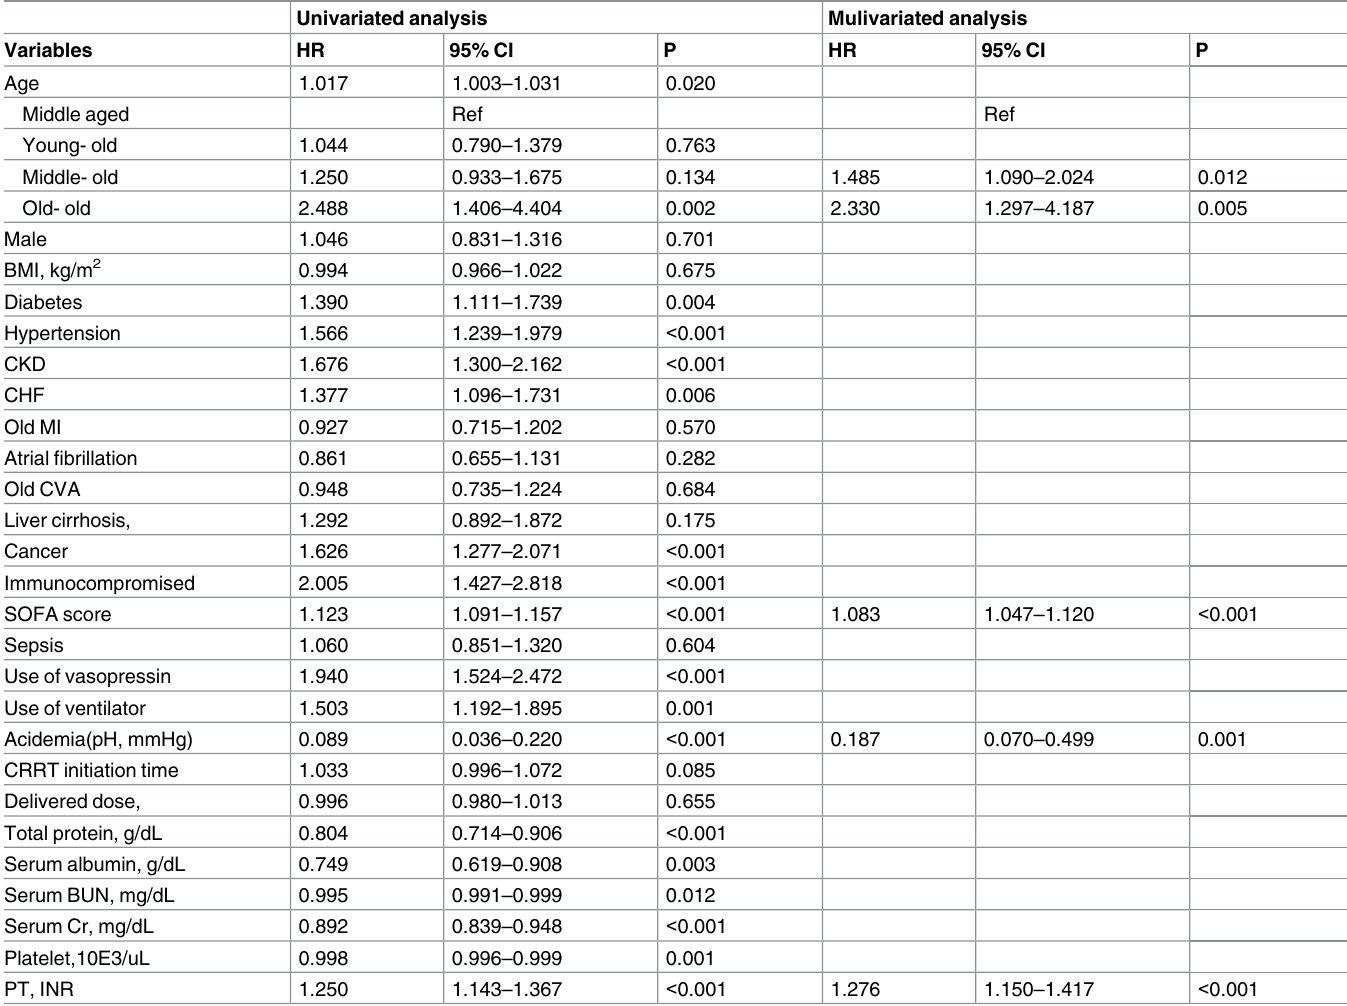
Table 3. Factors associated with short term